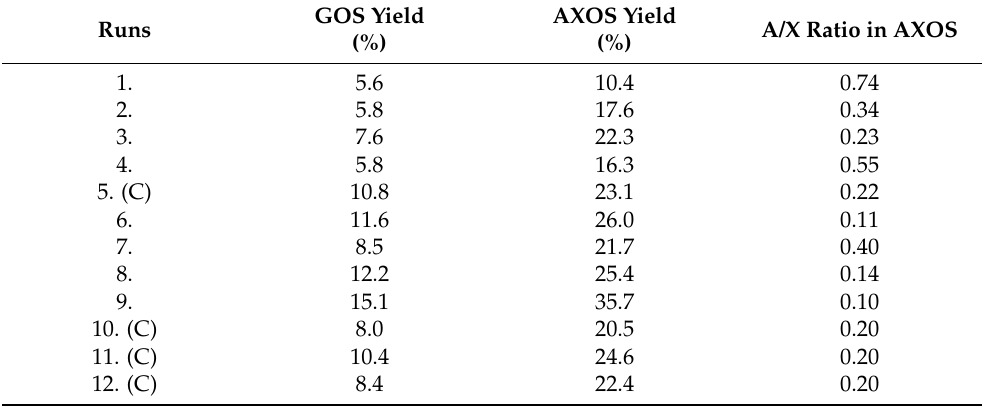
Table 2. Yields and composition (A/X ratio) of oligosaccharides obtained in the first acidic hydrolysis of